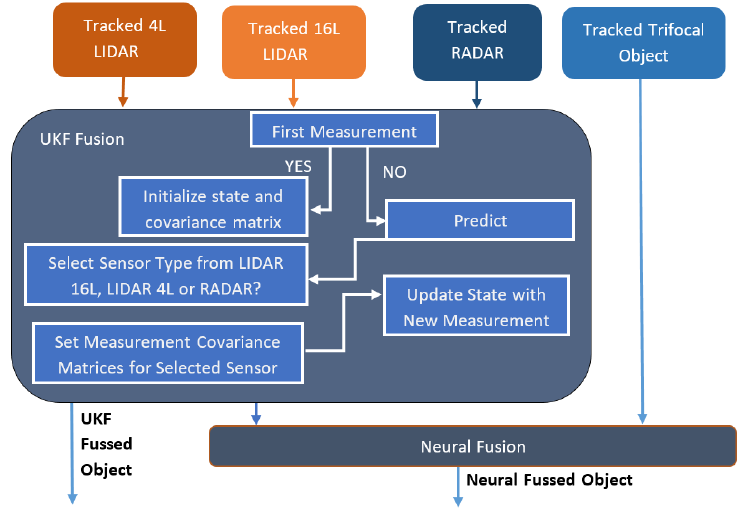
Figure 16. UKF (Unscented Kalman Filter) and neural fusion architecture.